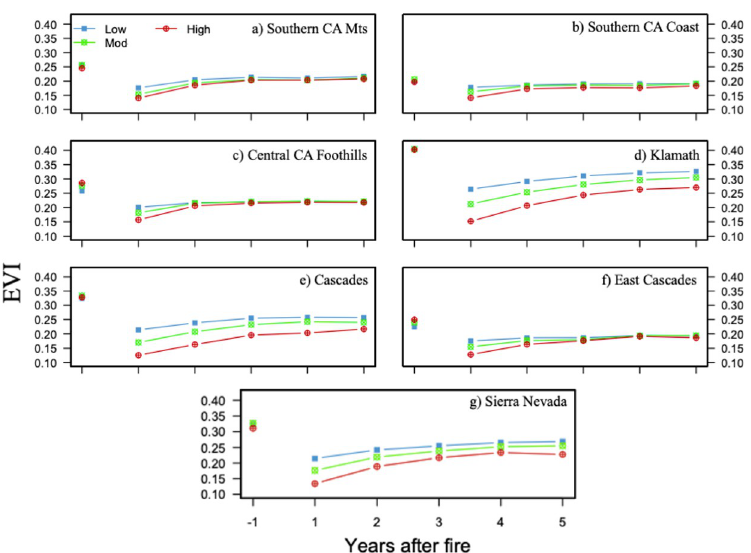
Fig 5. Prefire EVI and five-year early-summer postfire trajectory (a-g). Average early-summer postfire EVI for one- year pre-fire through five-years post-fire for each ecoregion SCM, SCC, CCF, K, C, EC, and SN. Prefire and postfire EVI are burned area